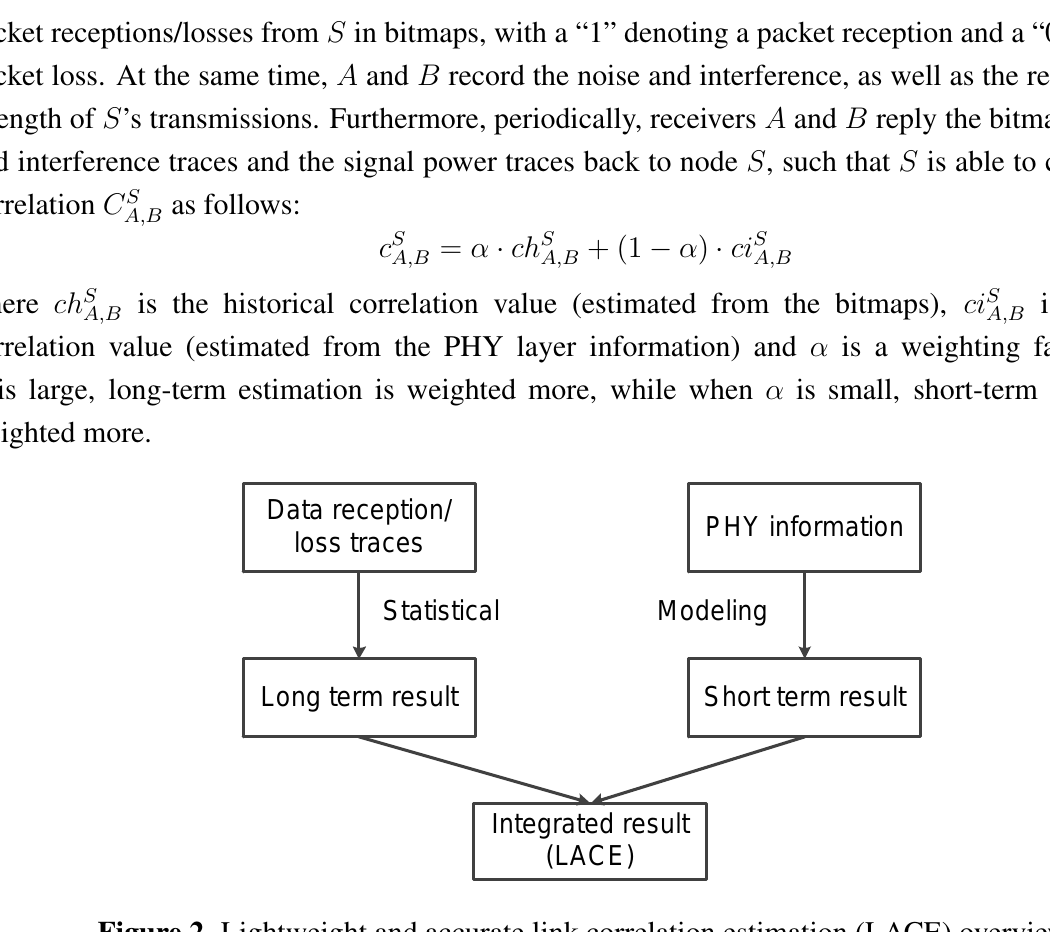
Figure 2. Lightweight and accurate link correlation estimation (LACE)